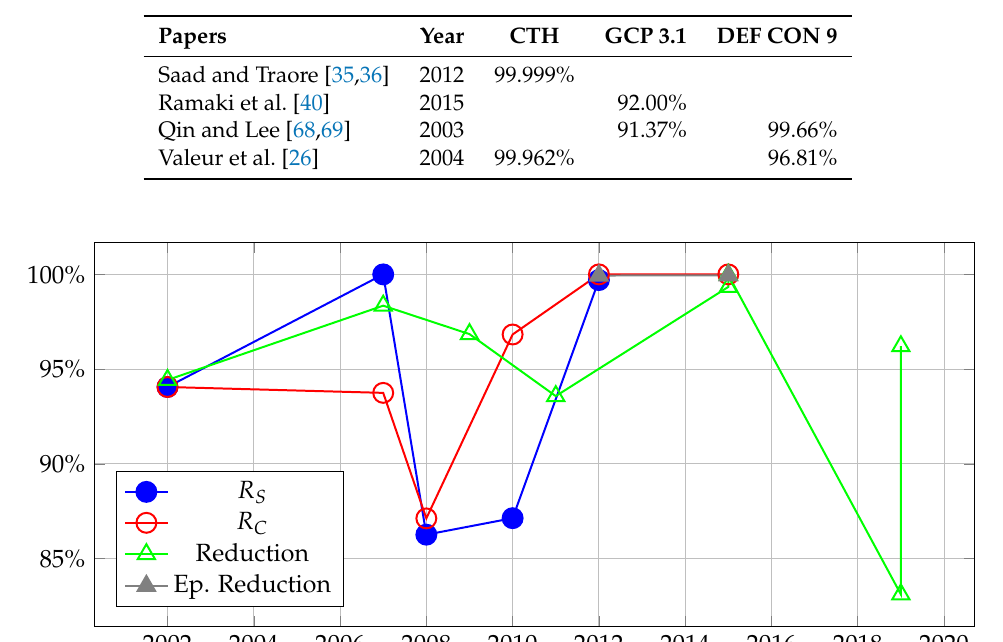
Table 6. Alert reduction results on Cyber Treasure Hunt (CTH), GCP 3.1, and DEF CON 9 datasets.